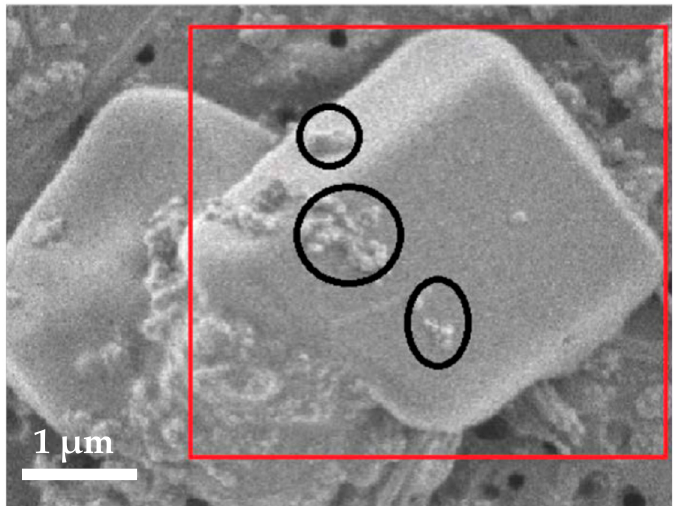
Figure 10. SEM image of a mixing sea-spray-soot as sampled on the Mediterranean coast using a Dekati impactor. The red square denotes a salt crystal, while the black circles show soot. The photograph is issued from aerosol samples acquired on the island of Porquerolles during the MATRAC experiments (Piazzola et al., 2020) [61].